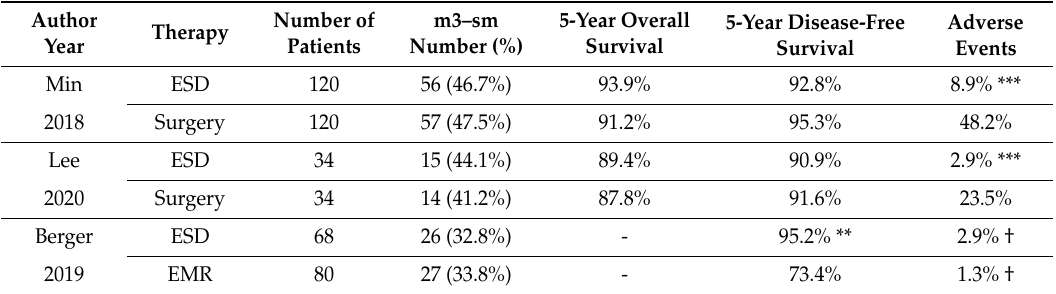
Table 4. Comparison between endoscopic submucosal dissection and other resection methods for superficial esophageal squamous cell